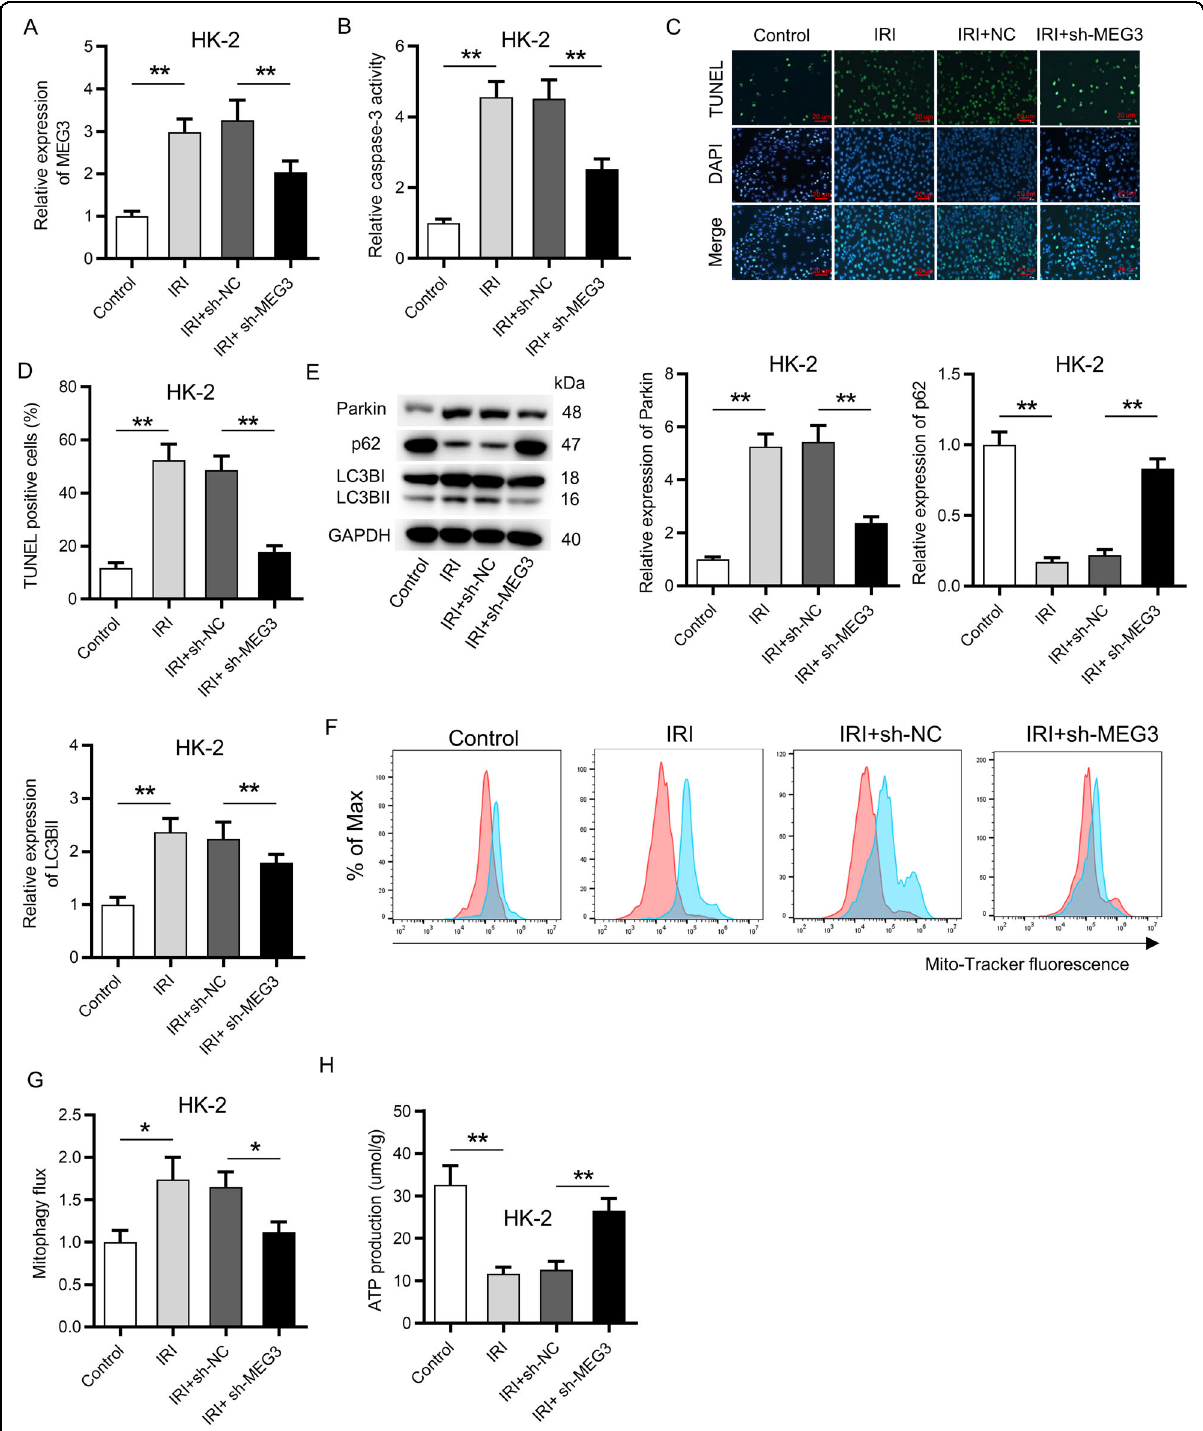
Fig. 2 Suppression of MEG3 inhibited apoptosis and mitophagy in vitro. A RT-qPCR showed the transfection ef fi ciency of sh-MEG3 in HK-2 cells. B A caspase-3 kit was applied to detect the activity of caspase-3 in sh-MEG3 transfected HK-2 cells. C , D A TUNEL assay revealed the in fl uence of MEG3 de fi ciency on apoptosis of HK-2 cells. E Western blot analysis indicated the protein levels of Parkin, p62, LC3B-I, and LC3B-II. F , G MitoTracker Green FM staining was used to evaluate mitophagy fl ux under the in fl uence of MEG3 de fi ciency. Red color indicated DMSO and blue color indicated Baf. H The in fl uence of MEG3 de fi ciency on ATP production was determined via an XFe96 extracellular fl ux analyzer. * p < 0.05, ** p < 0.01.